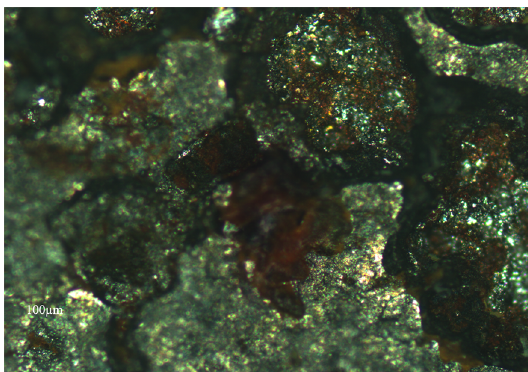
Figure 4. Image of the metallic surface of the API 5L X60 alloy in clayey soil with formation of corrosion products and pits formed on the metal